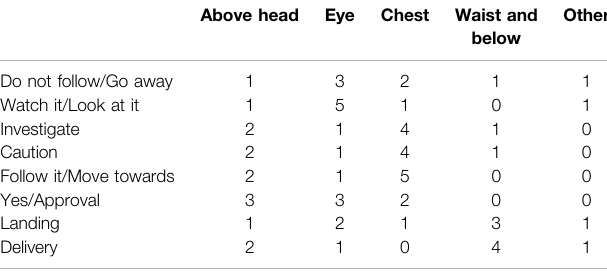
TABLE 6 | Participants ’ chosen height of operation by state.